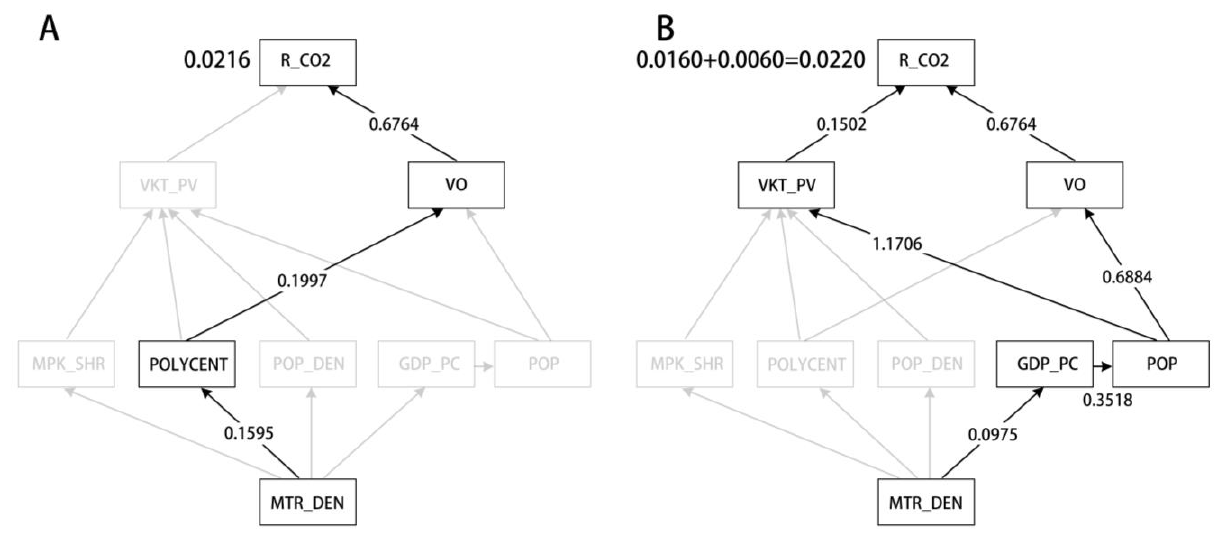
Figure 5. Positive Effects of Metro Density on Traffic-related Carbon Emissions: Mediators of ( A ) POLYCENT; ( B ) GDP_PC and POP. Source: Created by the authors from Table 4.